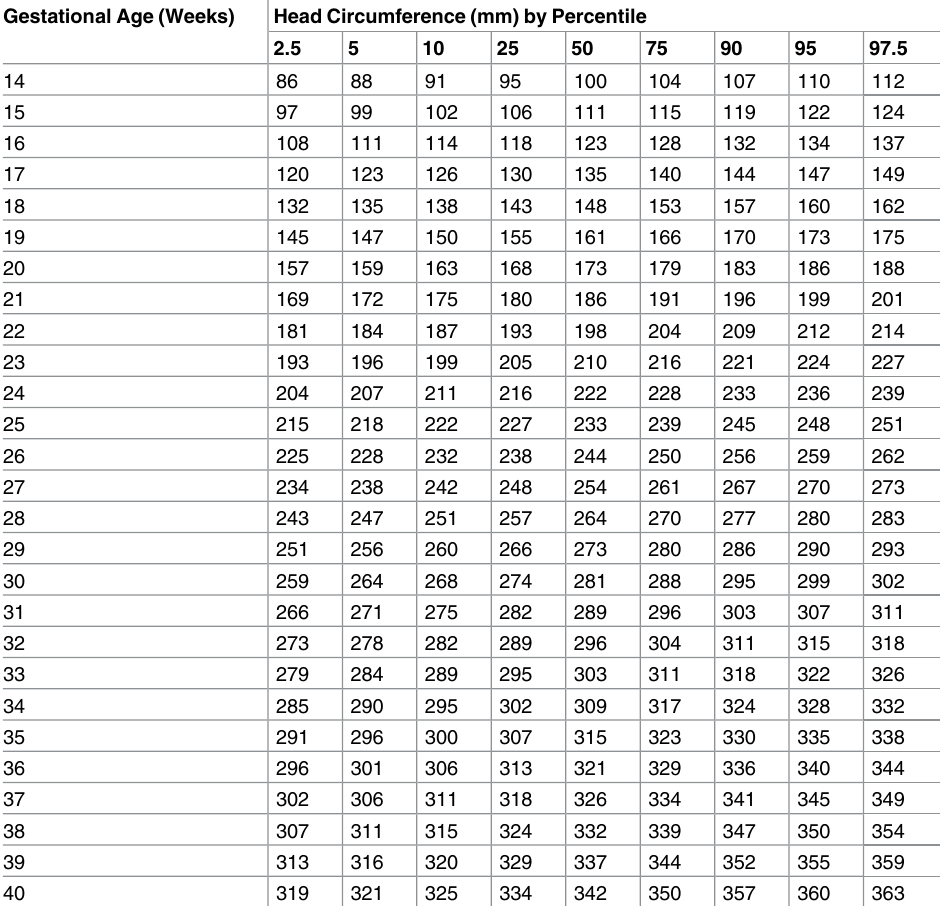
Table 7. Growth chart for fetal head